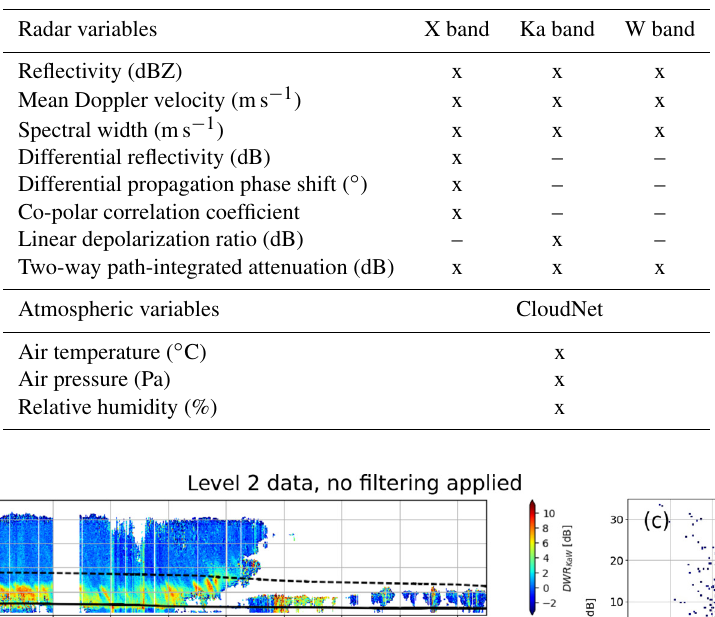
Table 5. Variables available in the TRIPEx dataset Level 2.